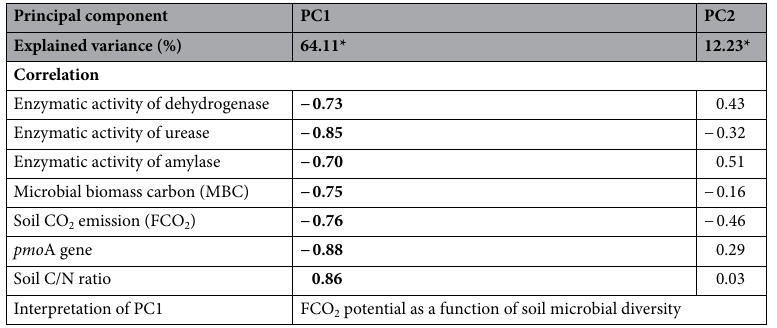
Table 4. Correlation between soil attributes and the first two principal components (PC1 and PC2). *Value referring to the percentage of variation of the original set of data retained by the respective principal components. Correlations in bold (higher than 0.70 in absolute value) were considered in the interpretation of the principal component.